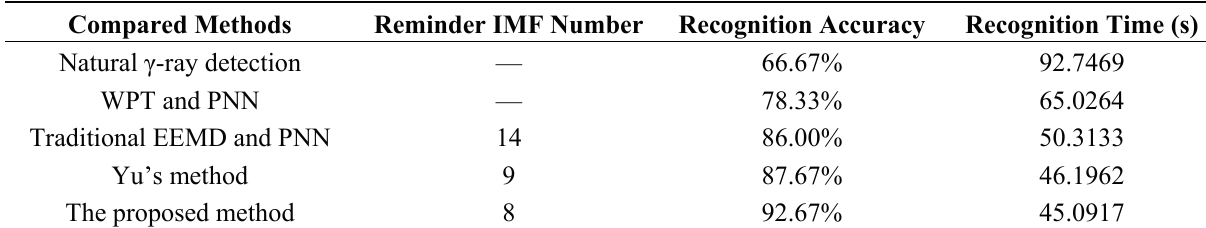
Table 4. Comprehensive performance of related